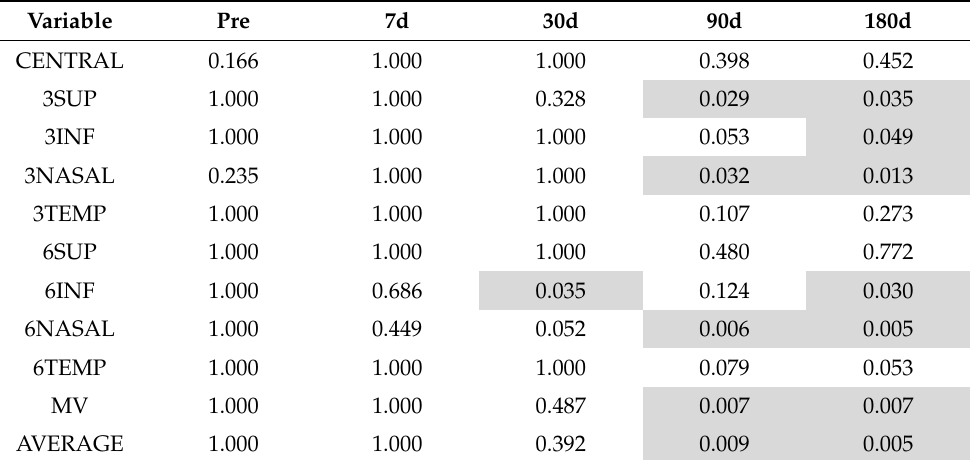
Table 2. P -values given by Wilcoxon test of comparison between operated and unoperated eyes. Differences with p -values < 0.05 are shown in shade.